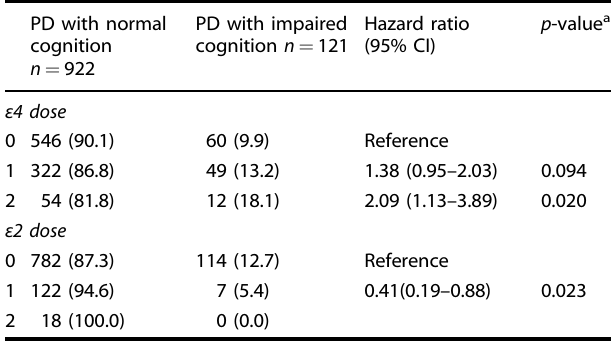
Table 3. Relationship between APOE ε 4 genotype dose and cognition status among Nigerians with Parkinson ’ s